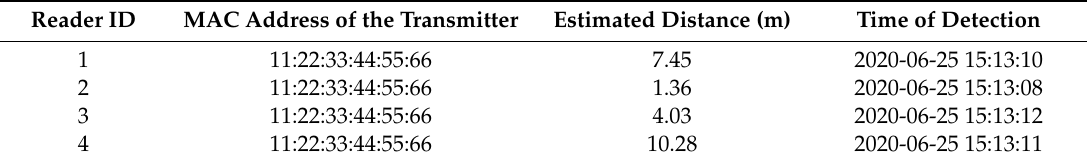
Table 1. Sample data collected by the gateway.